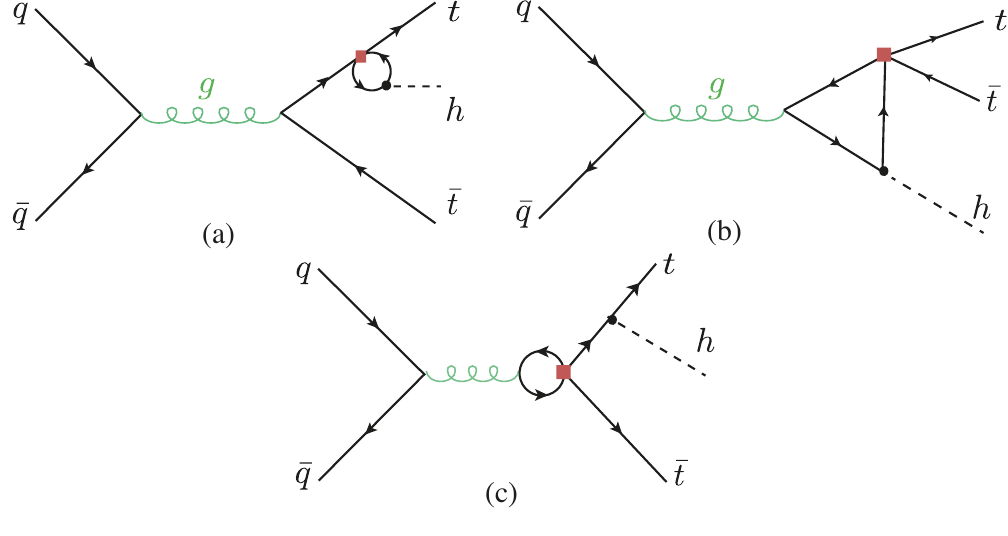
Figure 4 . Example Feynman diagrams including the four-fermion loop contributions to the qq → tth